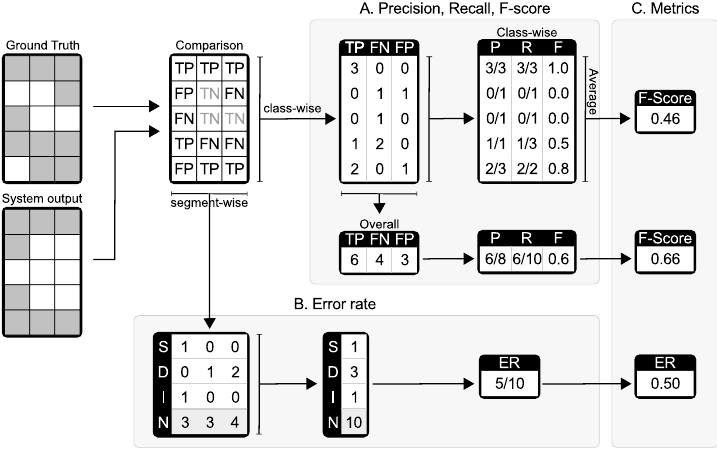
Figure 4. Calculation of segment-based metrics.